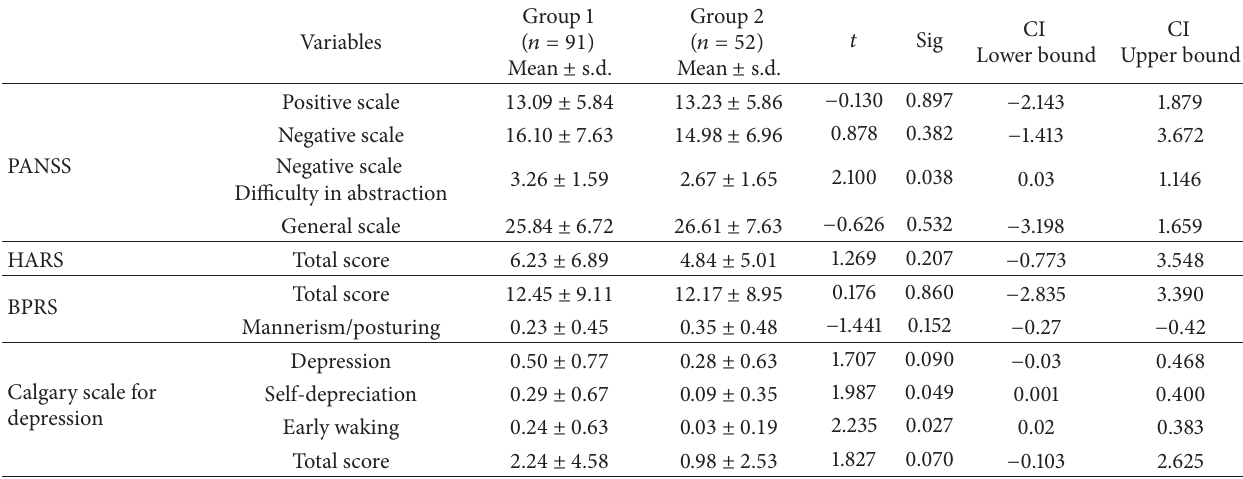
Table 4: PANSS, Calgary scale for depression, HARS, and BPRS scores at 6 weeks in schizophrenia patients with substance use disorder (Group 1) and without substance use disorder (Group